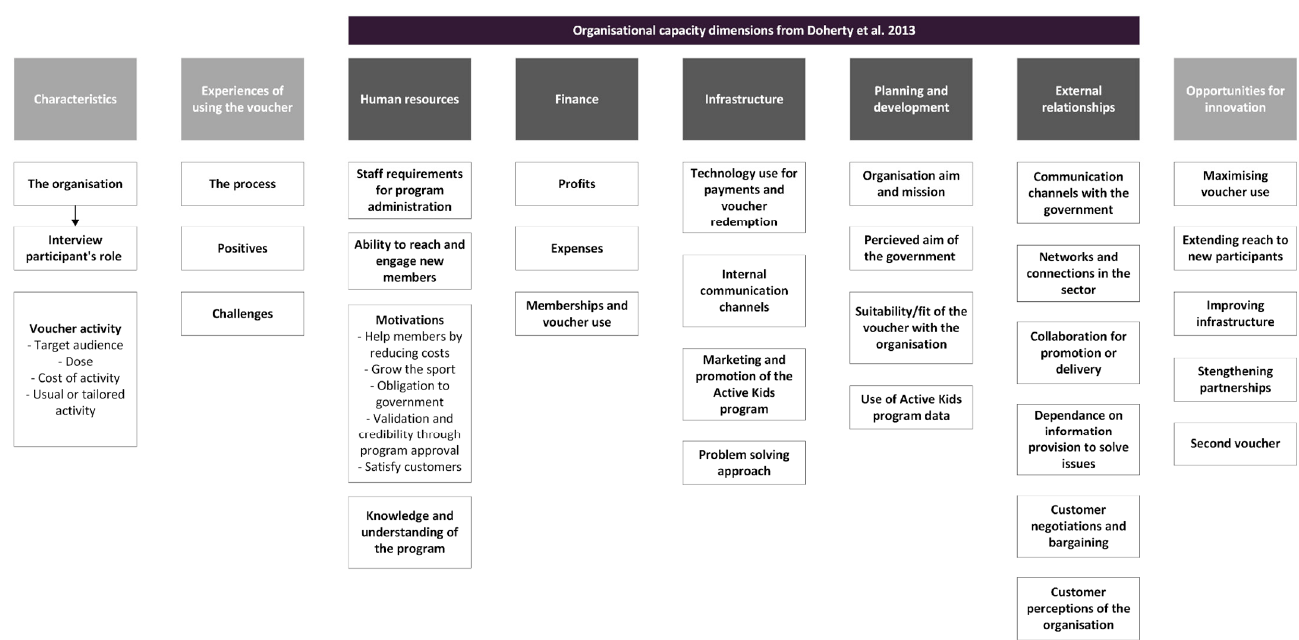
Figure 2. Coding framework for the interviews with Active Kids providers